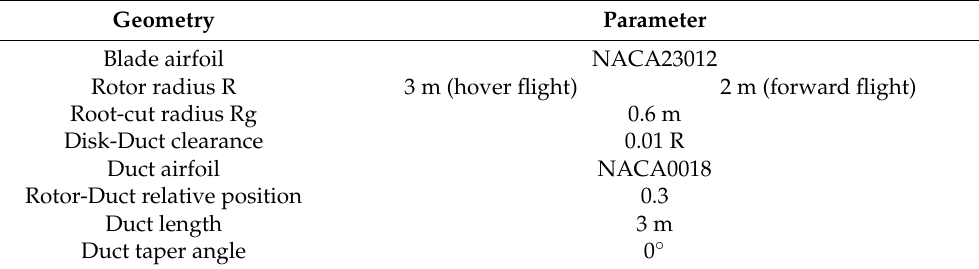
Table 4. Invariable geometric parameters of the rotor in the orthogonal experiment.